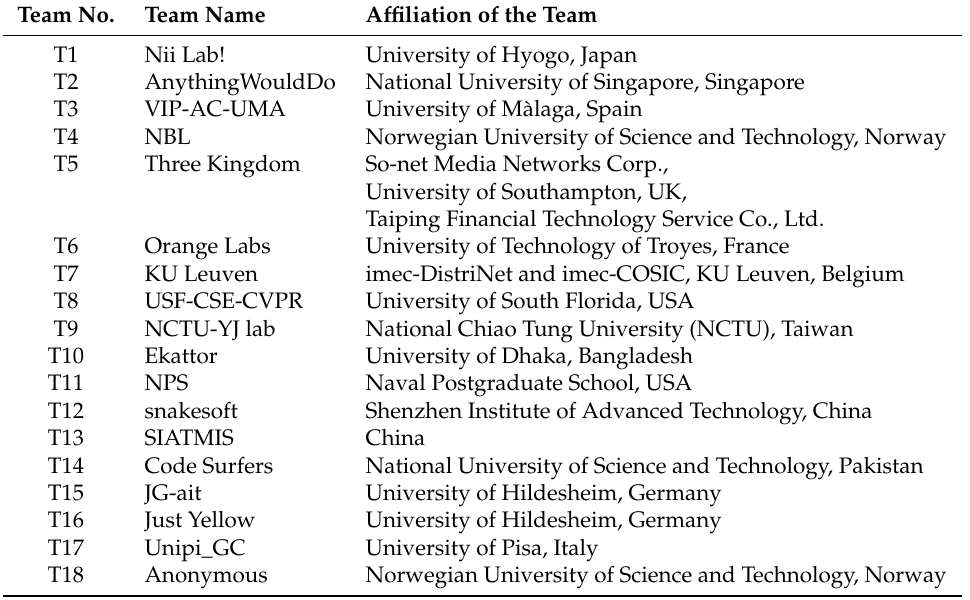
Table 1. Detailed information about the 18 registered teams for the competition. Team